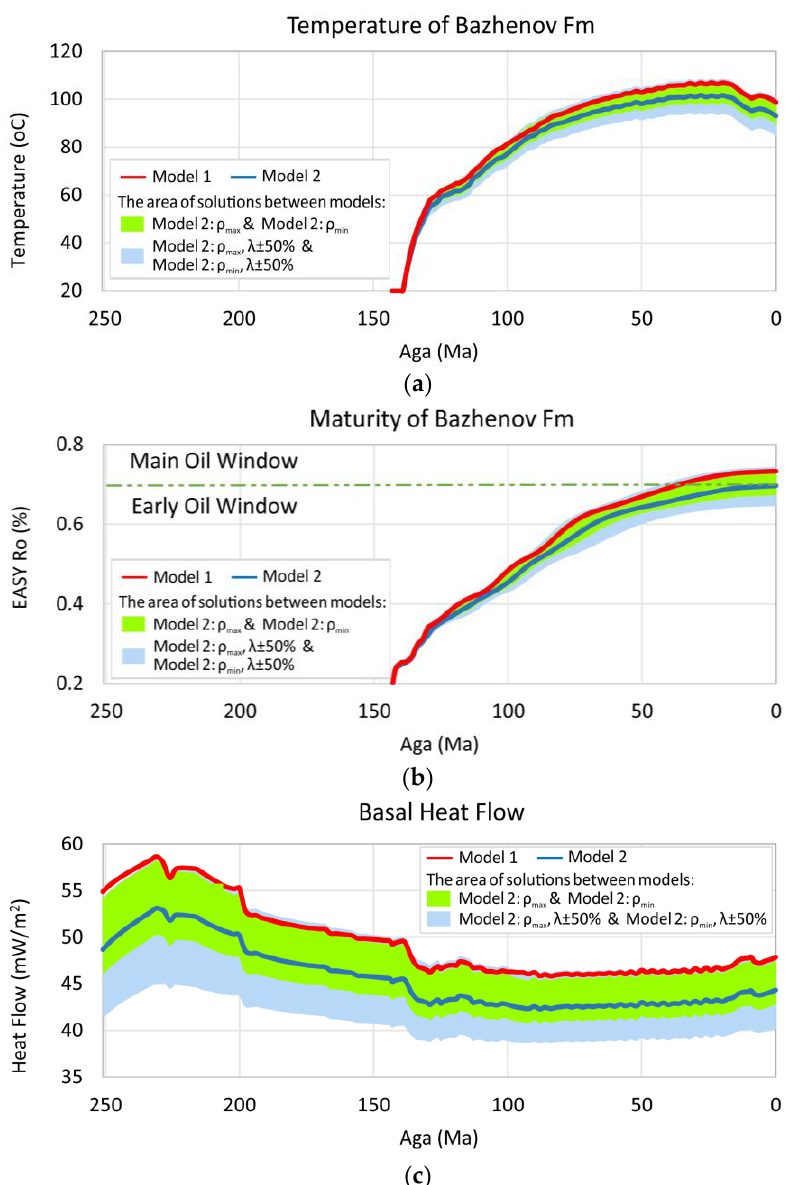
Figure 13. Extraction of the time-dependent ( a ) temperatures and ( b ) vitrinite reflectance by the EasyRo model [73] of the Bazhenov Fm surface and ( c ) basal heat flow at the 645 km section for all models. The lower boundary of the blue infill corresponds to Model 2: ρ min .